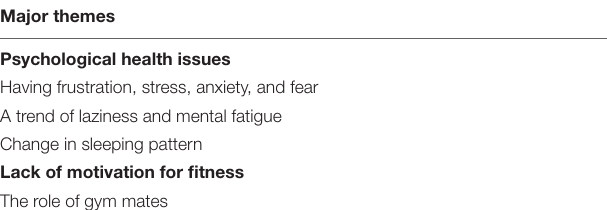
TABLE 3 | Major themes and subthemes that emerged from the interviews indicating participants’ experiences during the COVID-19